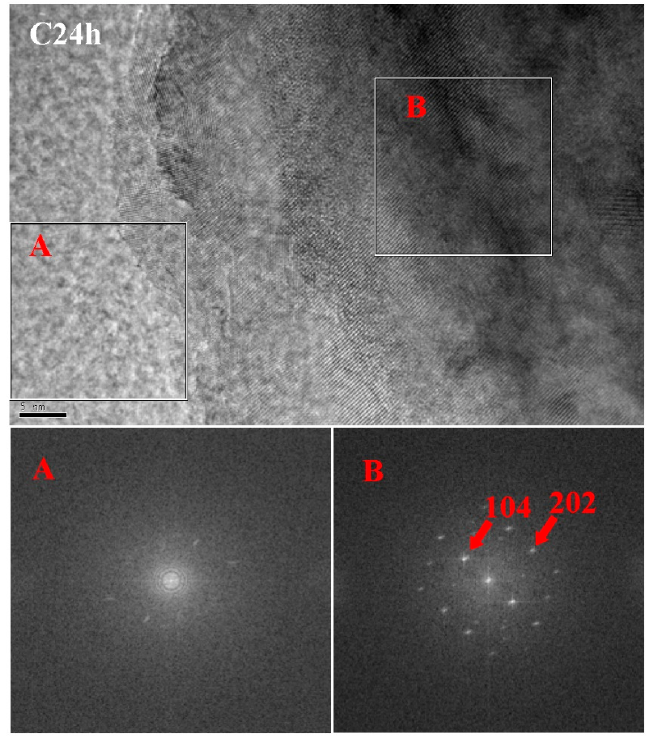
Figure 14. HRTEM image and selected area Fourier transform images of C24h.